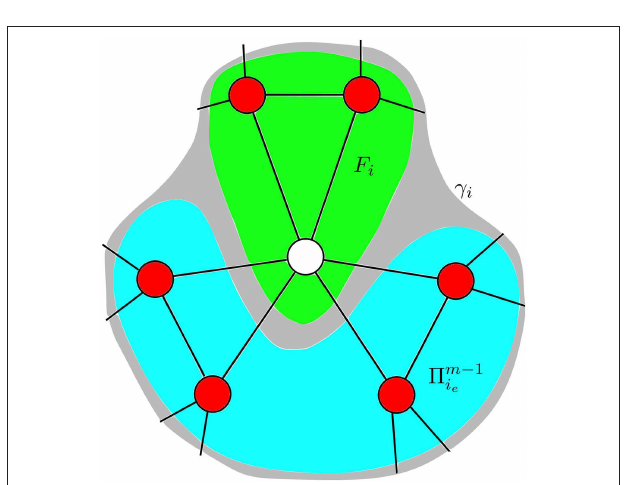
nodes in the network at time t is given by 1 / n We begin by calculating the probability, denoted 5 i , that at